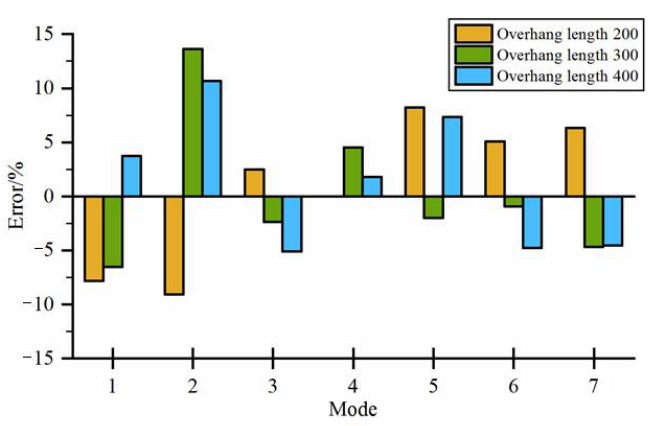
Figure 14. Natural frequency error under three working conditions.